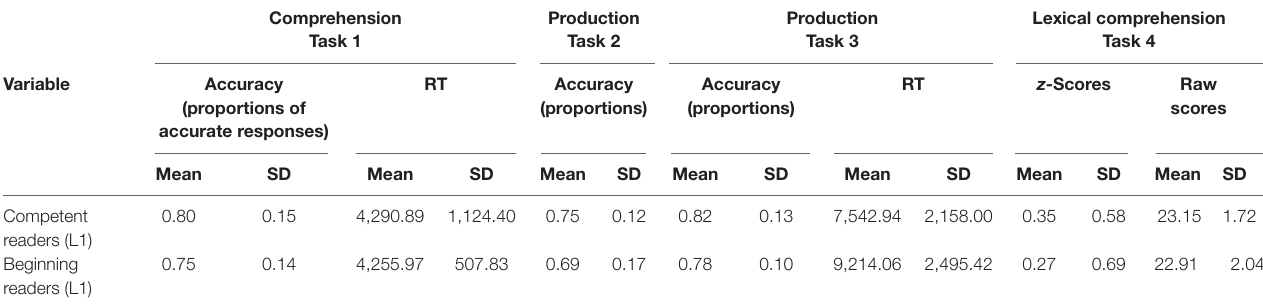
TaBle 1 | Descriptive statistics (mean and SDs) of all variables for the morphological awareness tasks and for the lexical comprehension task in the L1 competent and beginning readers